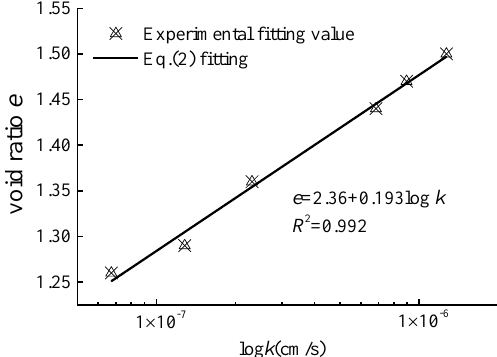
Figure 4. The relationship between the permeability coefficient k and void ratio e.